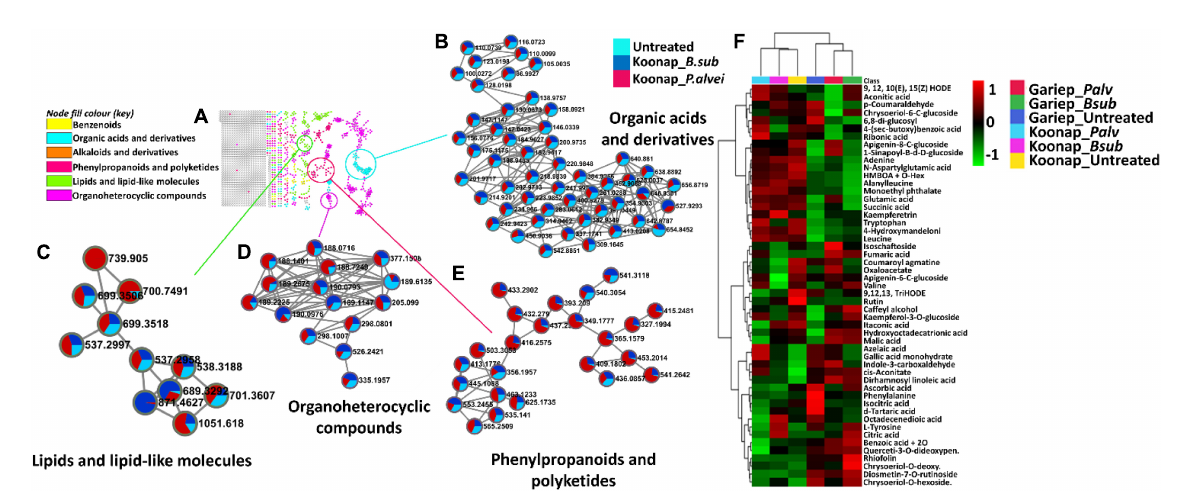
FIGURE7 A global leaf metabolome view of the plant growth-promoting rhizobacteria (PGPR)-treated/untreated Koonap rhizosphere (Gariep- Supplementary Figure 4 ) showing classes and distribution of detected metabolites driving the global differences between the treated and untreated rhizosphere soils. (A) Molecular network of MS/MS spectra generated with MolNetEnhancer (in GNPS) giving a metabolome coverage and classes of extracted metabolites from rhizosphere soil of PGPR-treated and untreated Koonap cultivar. Each displayed node represents a metabolite, while each cluster of pooled nodes (colored) depicts a class of chemically related and putatively annotated metabolites matched to GNPS libraries and databases. Gray nodes represent unmatched metabolites. (B–E) Shows clusters of organic acids and derivatives, lipids and lipid-like molecules, organoheterocyclic compounds and phenylpropanoids and polyketides respectively. Each node representing a metabolite shows the differential distributions and changes in the metabolites per treatment. (F) Is an interactive heatmap of all putatively annotated metabolites from leaf metabolome of PGPR-treated and untreated wheat cultivar showing general up/down regulation of metabolite classes per treatment. The heatmap was generated in MetaboAnalyst from average peak intensities of median-normalized, log transformed and Pareto -scaled